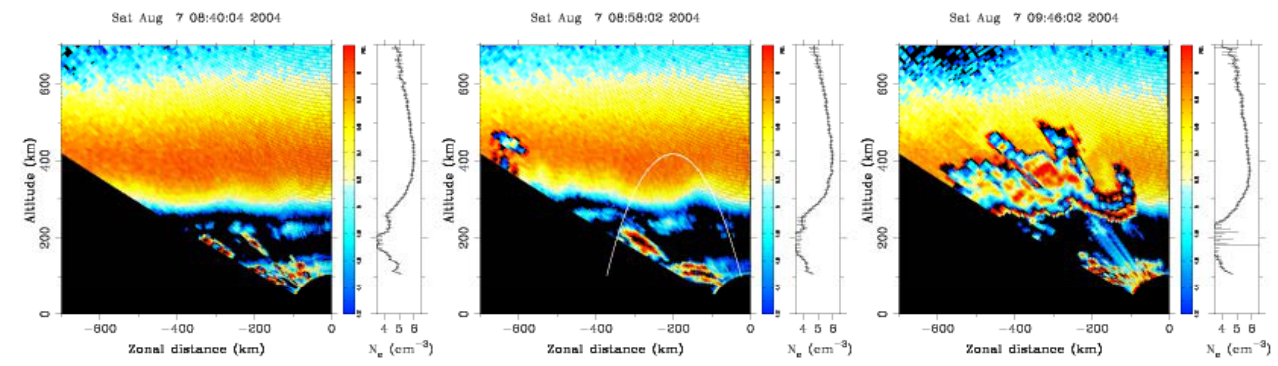
Figure 14. ALTAIR consecutive scans made before, during and after an instrumented rocket flown on August 15, 2004, showing the existence of an undulation of the bottom side of the F region, coincident with bottom-type Spread F patches, and the later development of plumes (after Hysell et al., 2005b).